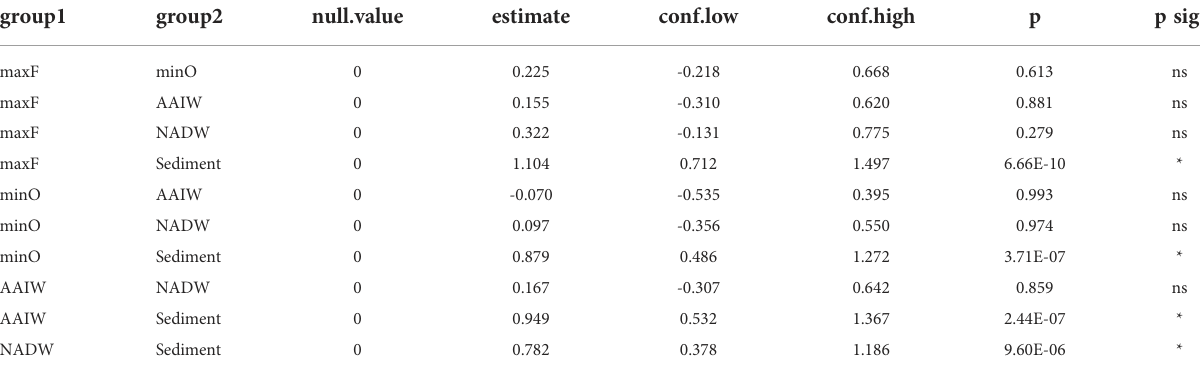
TABLE 1 Shannon diversity index among water masses and sediment were evaluated by two-way analysis of variance (ANOVA) followed by Tukey ’ s multiple comparison of means (p<0.05).